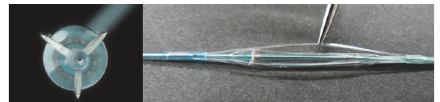
Figure 8: The NSE Alpha has 3 longitudinal nylon triangle elements mounted on the balloon surface to prevent balloon slippage during